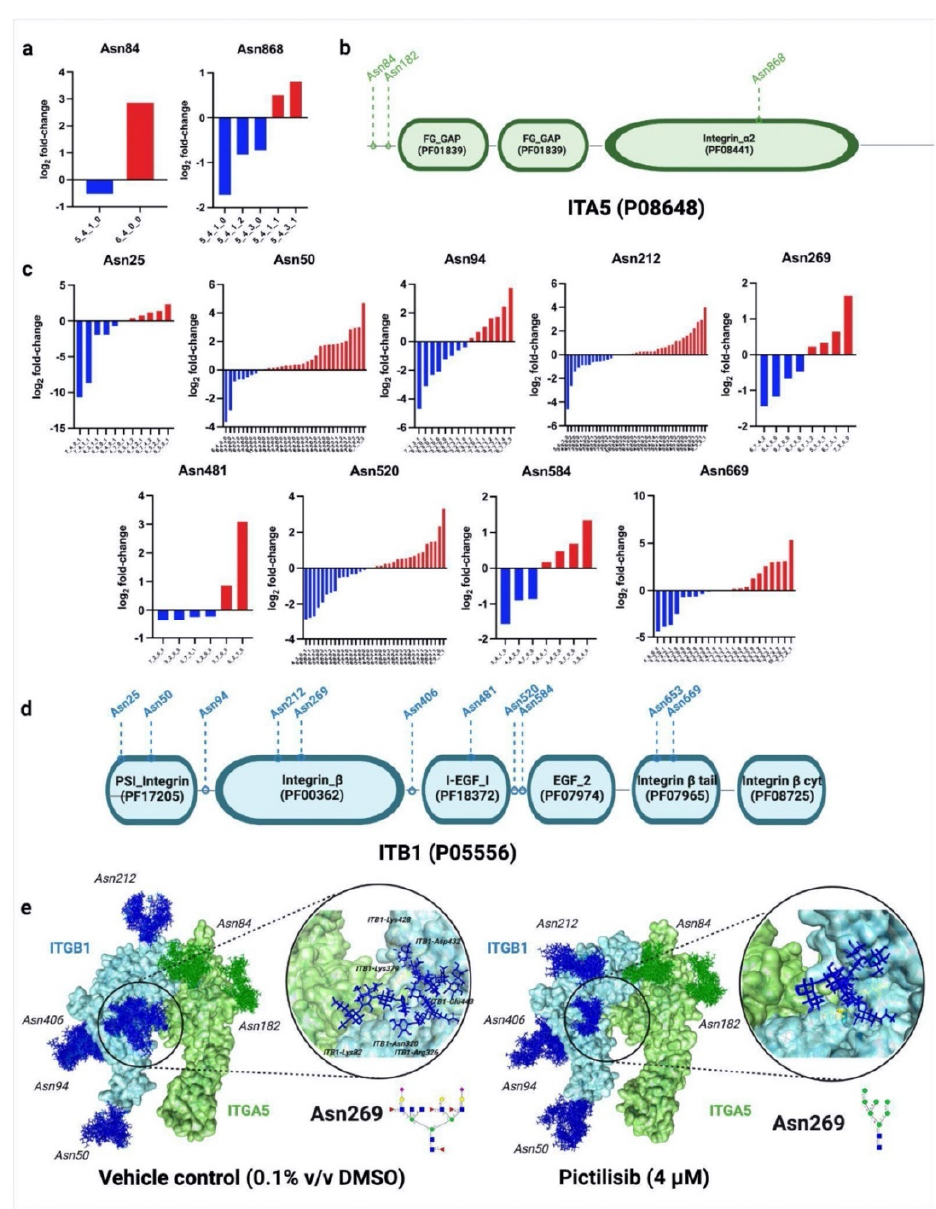
Figure 5. Site-specific glycosylation analysis of ITGA5-ITGB1 illustrates how specific glycosites potentially contribute to protein interactions. ( a ) Site-specific glycosylation of ITGA5 glycoprotein. Bar graphs represent log2 fold-changes in glycoform abundance following pictilisib treatment. Glycosite Asn182 did not change glycosylation; ( b ) Site-specific glycosylation overlaid with protein domain information of ITGA5, annotated using PFAM (http://pfam.xfam.org/, accessed on 15 May 2021); ( c ) Site-specific glycosylation of ITGB1 glycoprotein. Bar graphs represent log2 fold-changes in glycoform abundance following pictilisib treatment. Glycosites Asn406 and Asn653 did not change glycosylation. The X -axis represents glycoforms, annotated as Hex a HexNAc b Fuc c Sia d ; ( d ) Site- specific glycosylation overlaid with protein domain information of ITGB1, annotated using PFAM (http://pfam.xfam.org/, accessed on 15 May 2021); ( e ) 3D trajectories of ITGA5-ITGB1 glycoprotein complexes following treatment with pictilisib. Specific glycoform structures can be seen in Table S7 (Supplementary Materials). Dynamics simulation of negative control (Video S1, Supplementary Materials) and pictilisib-treated (Video S2, Supplementary Materials) are also